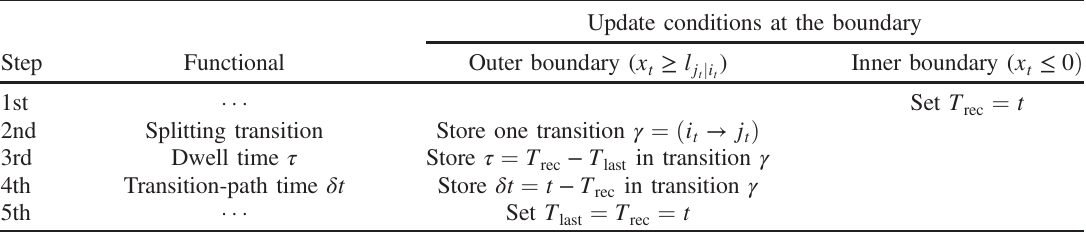
TABLE III. Update of dwell- and transition-path-time functionals. The initial position is assumed to be x 0 ¼ 0 , 0 along with the time of the last state change to T 0 . Each and time of the last recurrence is initially set to T rec ¼ last ¼ passage across an outer boundary results in a transition-path time δ t and dwell time τ that correspond to one transition event along a single transition γ